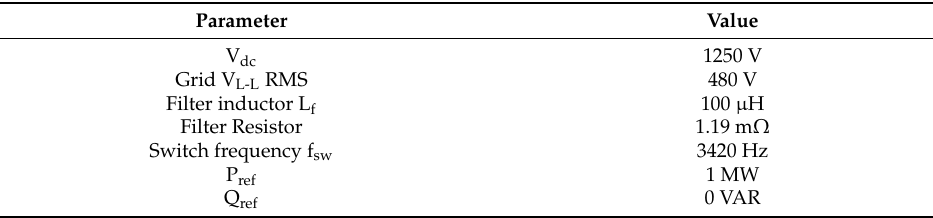
Table 1. System parameters [25].